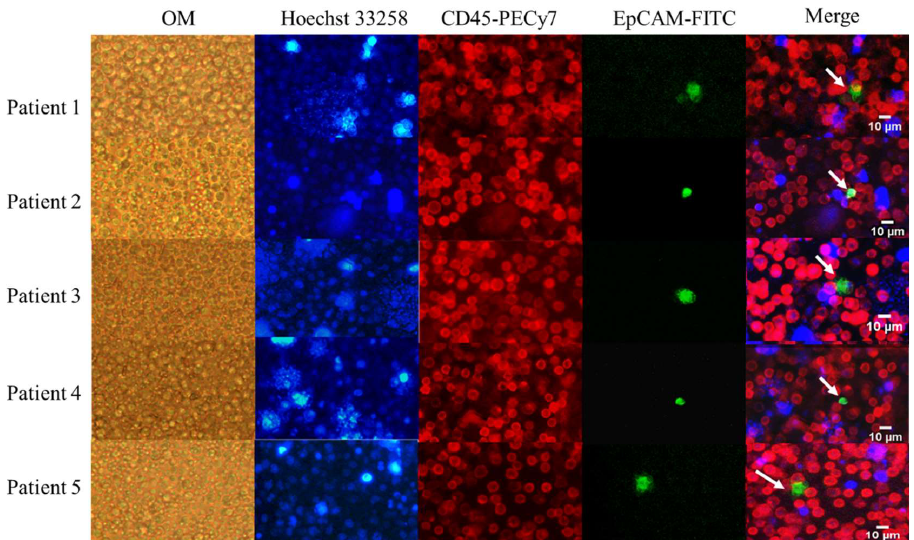
Figure 2. Detection of circulating tumor cells (CTCs) in peripheral vein blood (PB) from colorectal cancer (CRC) patients. The images were acquired on the microscope at 10 × magnification. OM: bright- field images under optical microscopy. The target cells are marked with white arrows. Blue: Hoechst 33258; Red: CD45-PECy-7; Green: EpCAM-FITC.